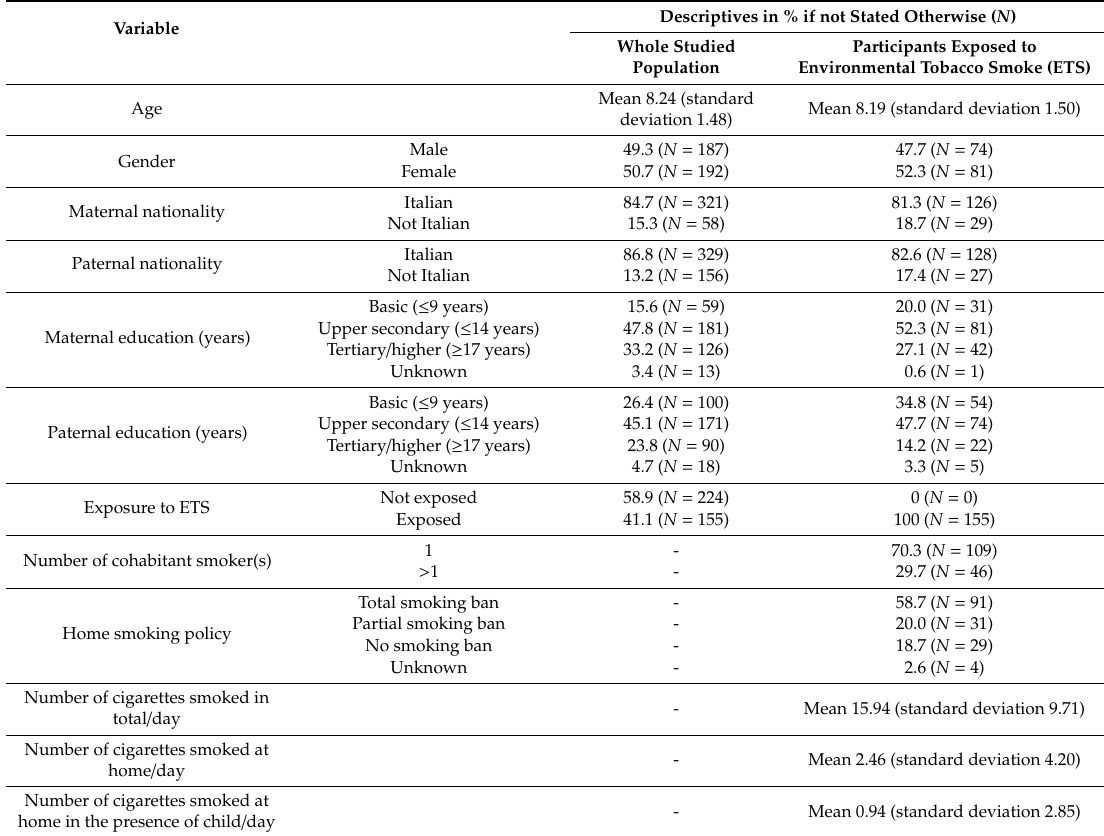
Table 1. Characteristics of the study population and of the participants exposed to Environmental Tobacco Smoke